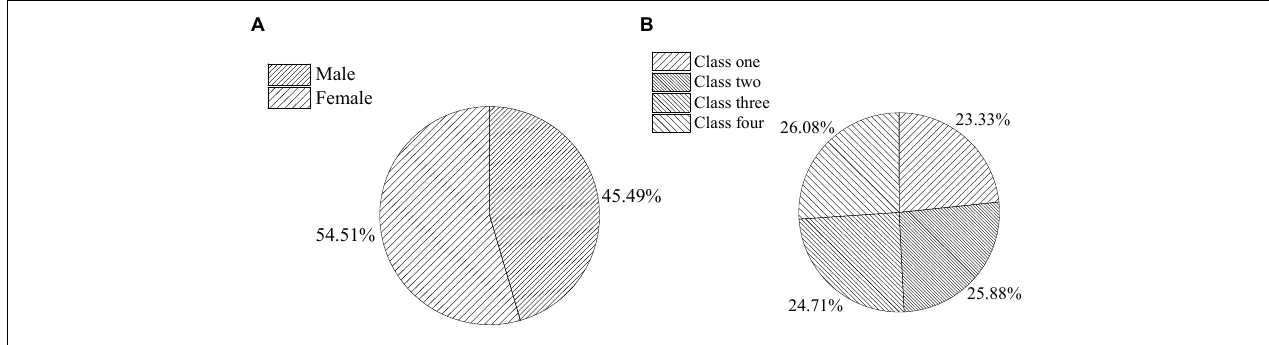
Frontiers in Psychology |